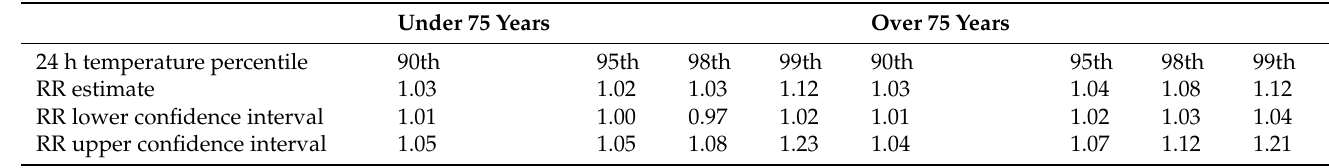
Table 1. Stratified relative risks (RRs) of heat deaths in